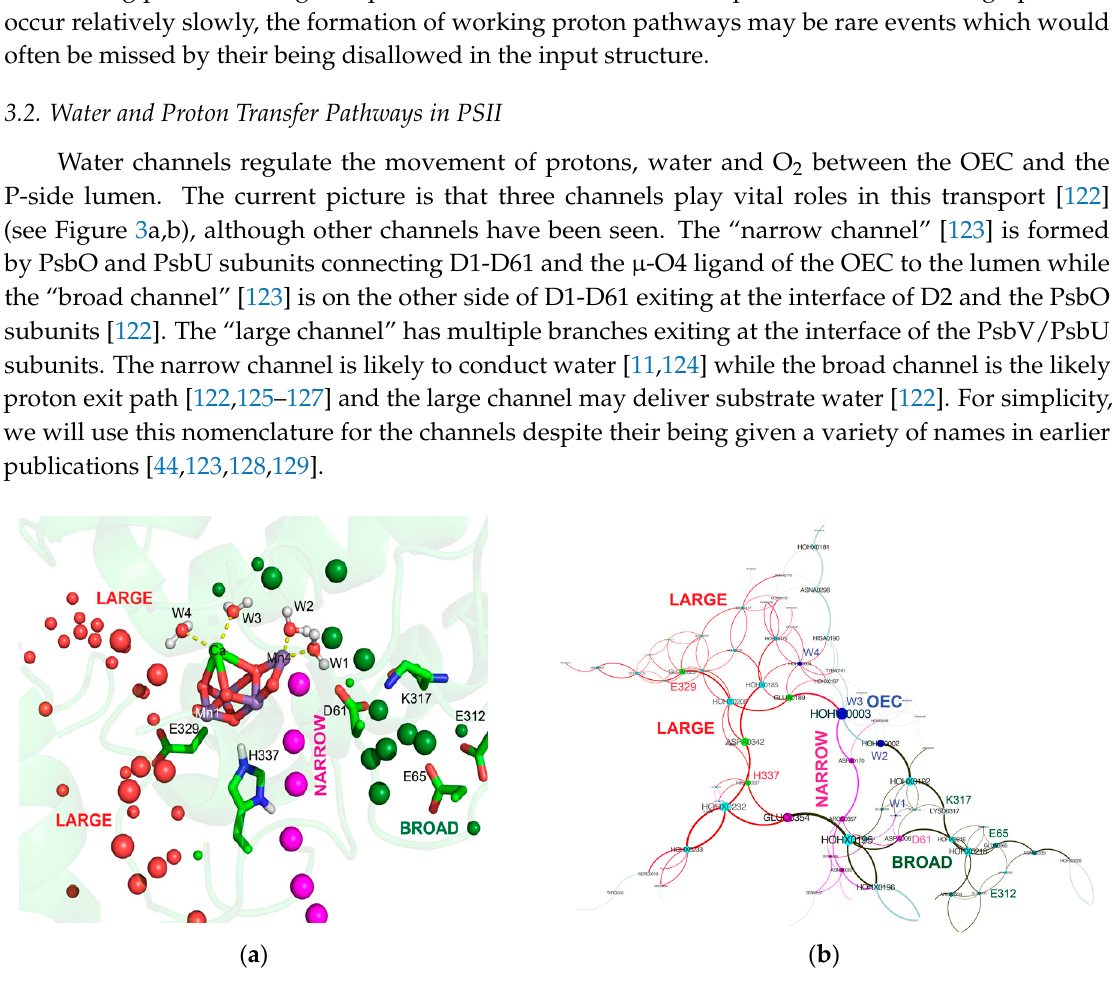
Figure 3. ( a ) Water channels around the OEC. The QM/MM hydrated, optimized S 1 cluster is docked into the 3ARC [106] PSII structure. Red: large channel, pink: narrow channel; green: broad channel. ( b ) Hydrogen bond connections for residues in narrow, broad and large channels that are connected through cluster of water molecules as determined by MCCE network analysis [119].